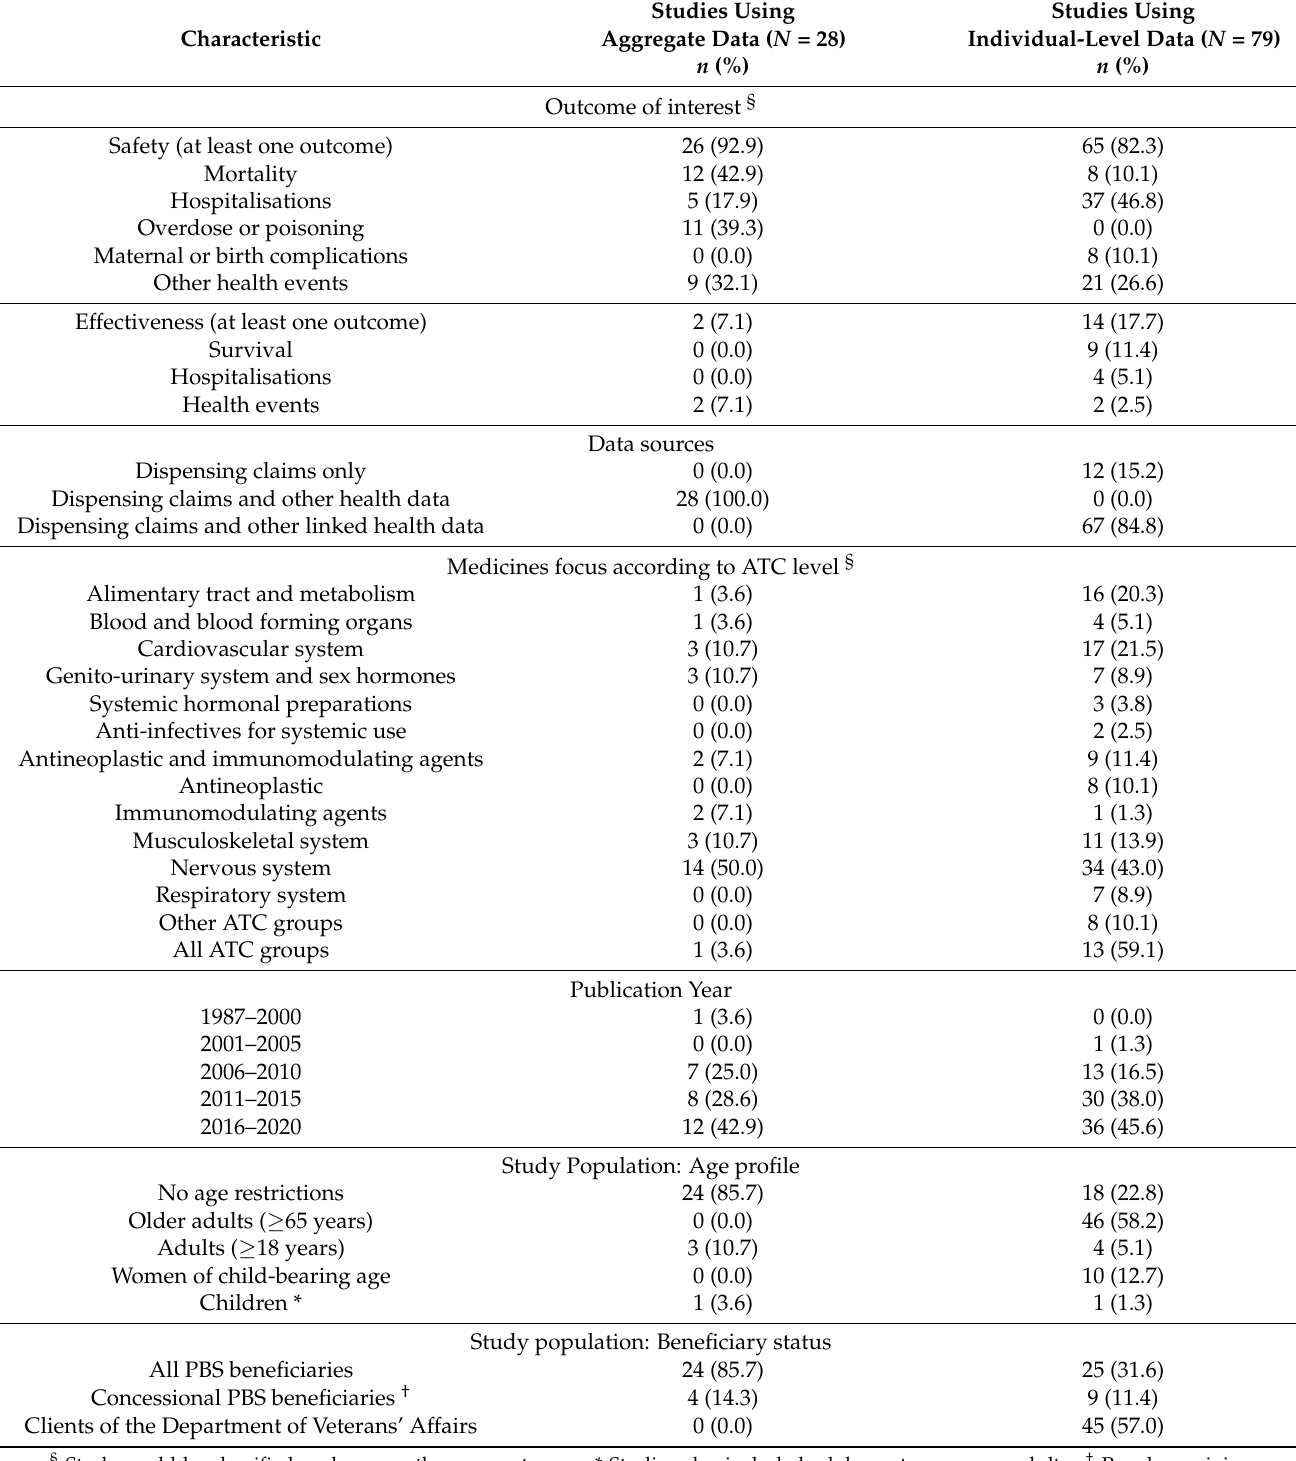
Table 3. Characteristics of Australian studies assessing medicine use and health outcomes